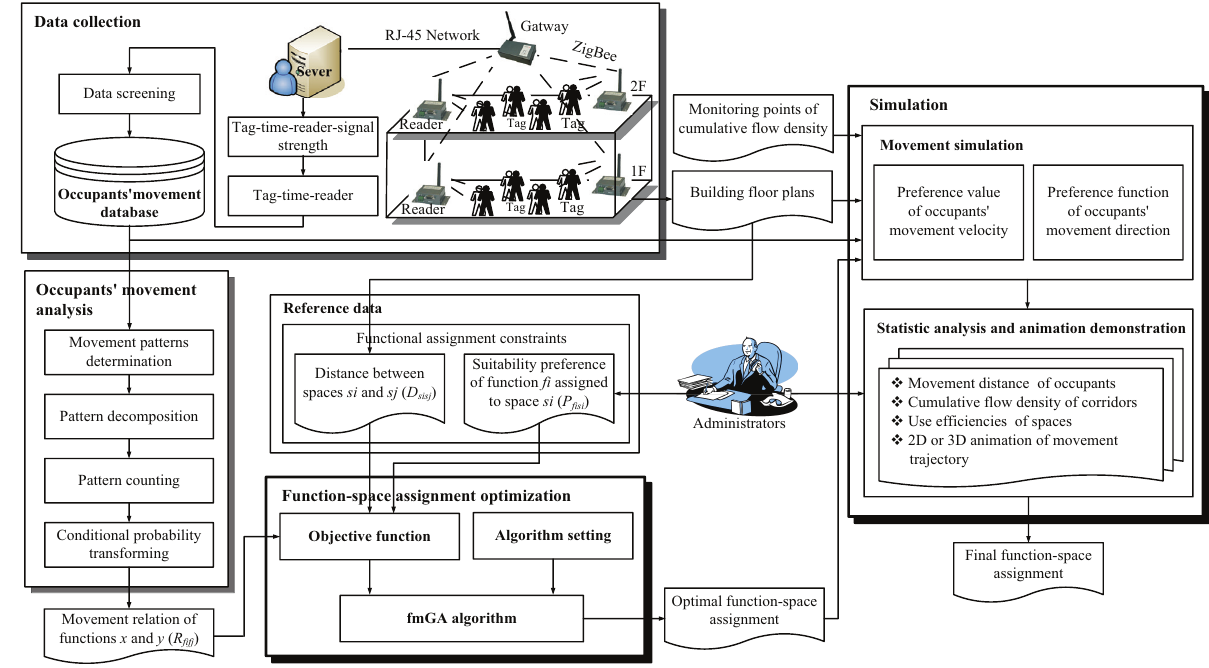
Fig. 1. Framework of FAMOS model